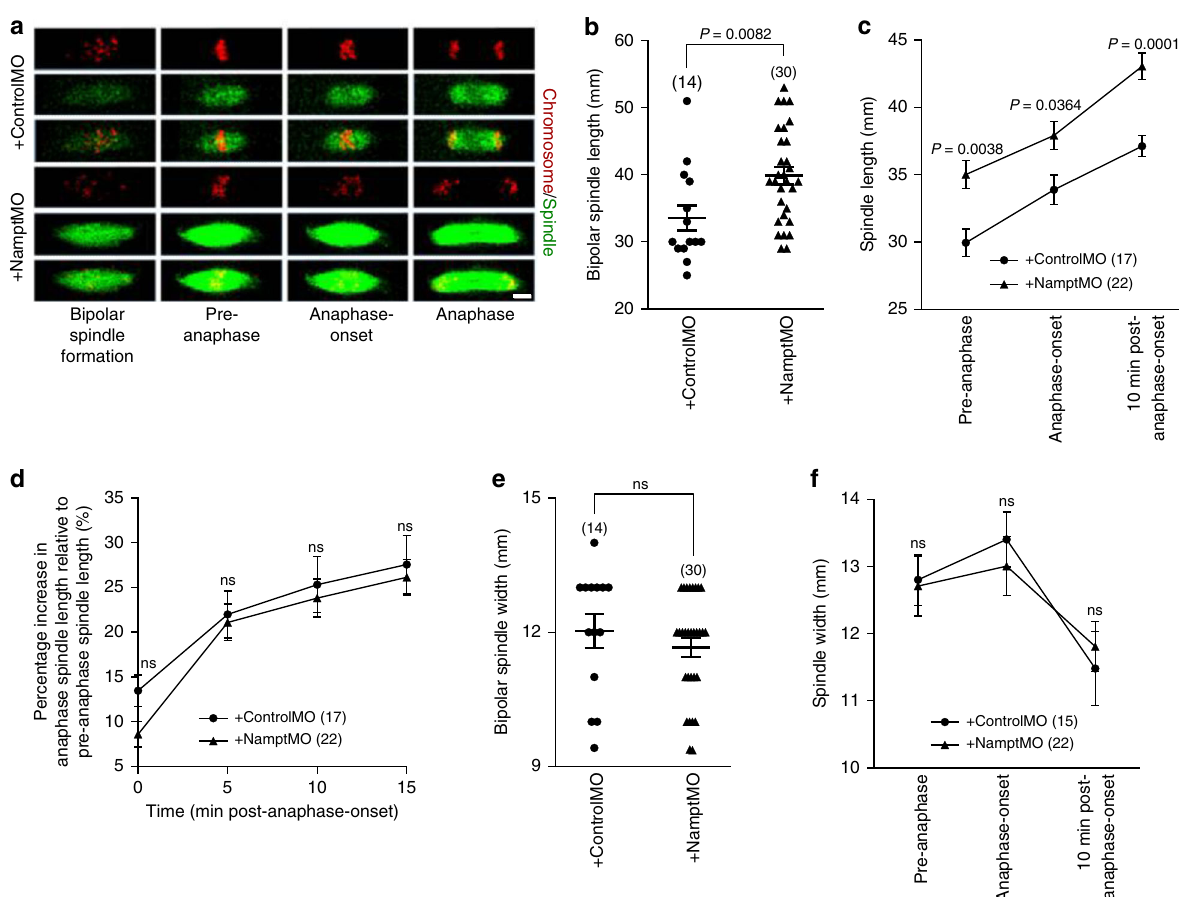
Fig. 3 Nampt-depletion increases spindle length but not anaphase-spindle elongation. a Shown are panels comprised of selected frames from representative time-lapse series of oocytes with SiR-tubulin-labelled spindles and expressing H2B-RFP to label chromosomes. Scale bar, 10 μ m. Representative images from three independent experiments are shown. b Spindle length at the time when bipolar spindles fi rst formed. c Measurements of spindle lengths at 5 min prior to anaphase-onset (pre-anaphase), anaphase-onset and 10 min post-anaphase-onset. d Percentage increase in spindle length during anaphase relative to pre-anaphase-spindle length. e Spindle width at the time when bipolar spindles fi rst formed. f Spindle width at pre-anaphase, anaphase-onset and 10 min post-anaphase-onset. Oocyte numbers are shown in parenthesis from three independent experiments ( b – e , f ). Data in graphs are presented as the mean ± SEM. P -values are shown in the graphs, ns denoted P > 0.05. Statistical comparisons were made using either two-tailed Student ’ s t -test in b and e or two-way repeated measures ANOVA in c , d and f . Source data are provided as a Source Data fi